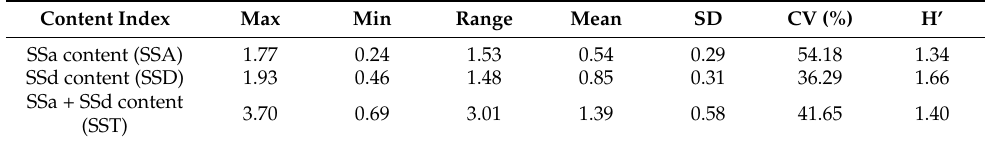
Correlation analysis of 12 trait indicators (including major agronomic and